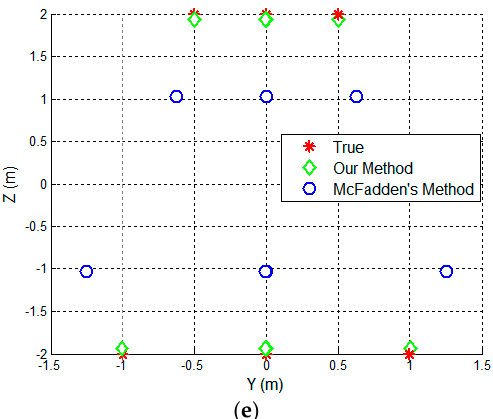
Figure 8. The reconstructed result using the proposed method. ( a ) The distribution of the reconstructed 3D scattering centers before transformation; ( b ) The distribution of the 3D scattering centers after transformation; ( c ) the distribution on XY plane; ( d ) the distribution on XZ plane; ( e ) The distribution on YZ plane.